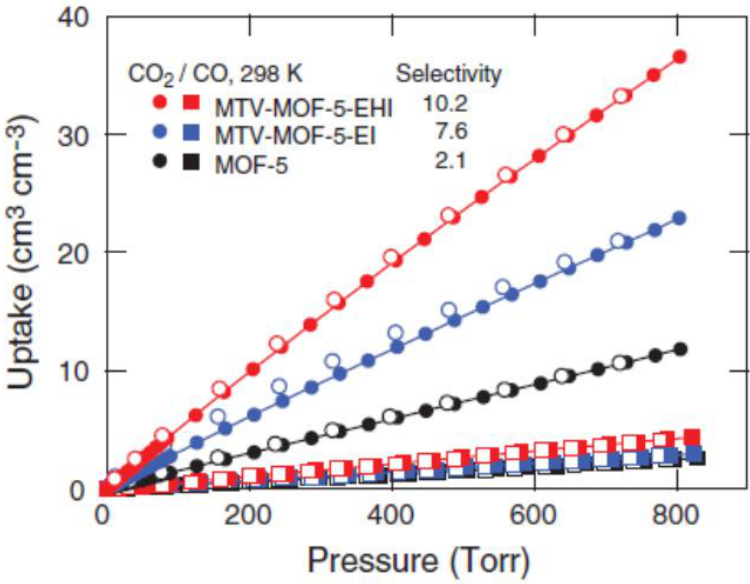
Figure 31. Several MTV-MOF-5s exhibit enhanced CO H : (C H O) -BDC; I : (C H O) -BDC. Reprinted with permission from [144]. Copyright 3 5 2 7 7 2 2010, American Association for the Advancement of